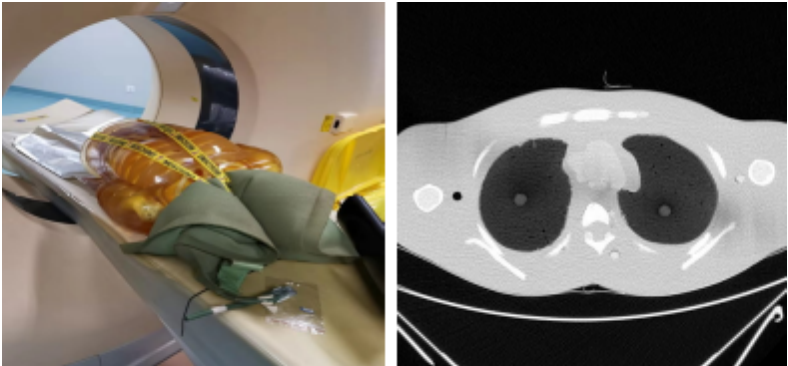
Figure 8. Lung phantom placed in CT scanner and a single axial slice.